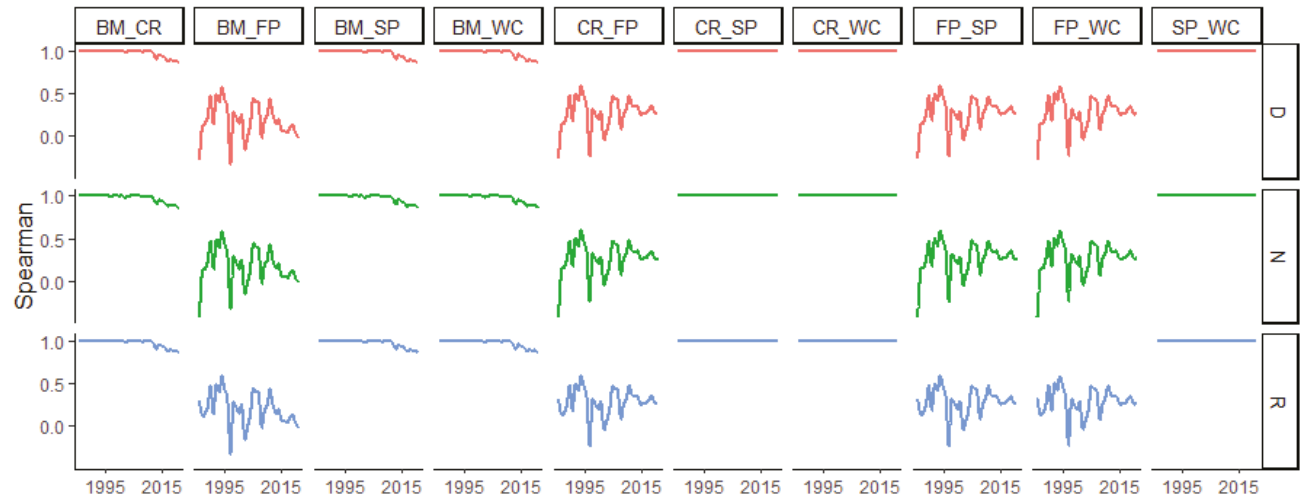
Figure 11. Significant correlation coefficient changes between pairwise ecosystem services during 1986–2021 (_ represents different pairs of ecosystem service functions—for example, BM_CR is the pair of BM (biodiversity maintenance) and CR (climate regulation)). D: disturbance area, N: natural area, R: reclamation area.